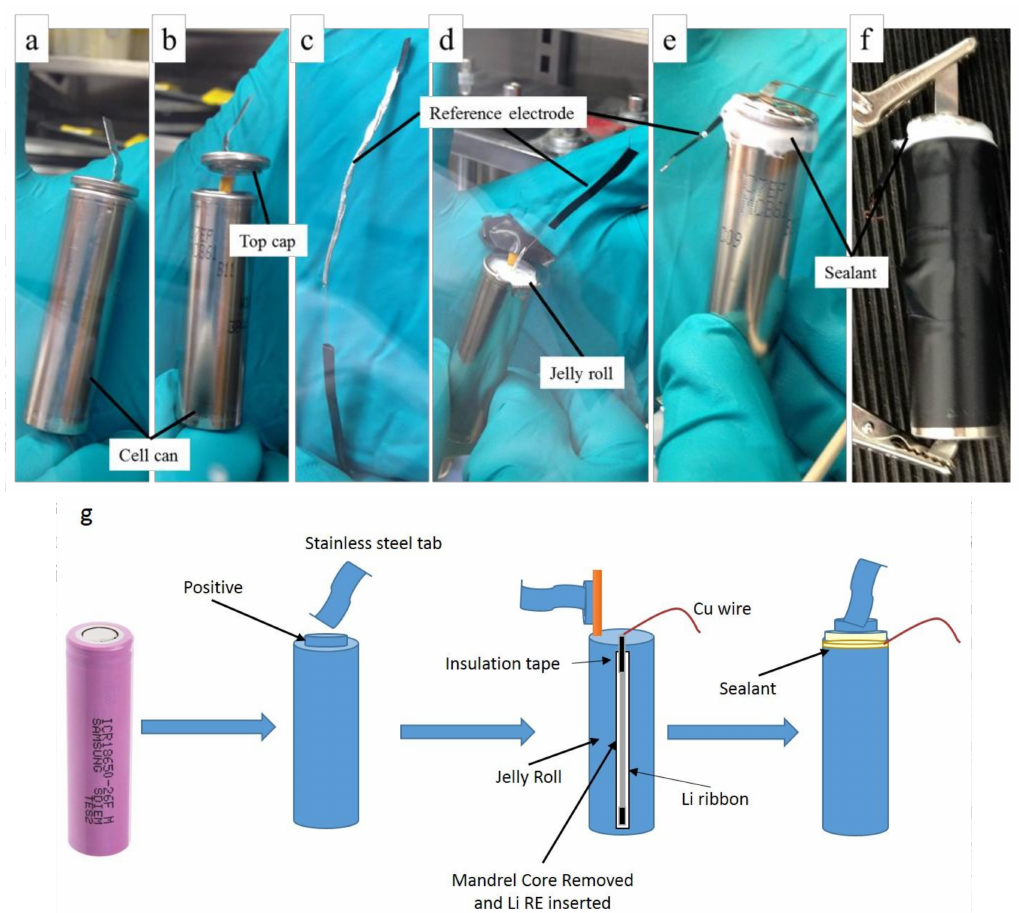
Figure 2. Images taken of a method to open, insert, reseal, and then prepare for electrical characterization of a commercial 18650 lithium-ion cell. ( a ) The pre-tabbed fresh cell; ( b ) separated top cap; ( c ) the RE: Li metal ribbon on Cu wire current collector (black insulation tape at the top and at the bottom); ( d ) inserting the RE in the mandrel core; ( e ) resealing the cell; ( f ) the cell ready for electrical characterization; and ( g ) the schematic diagram of the